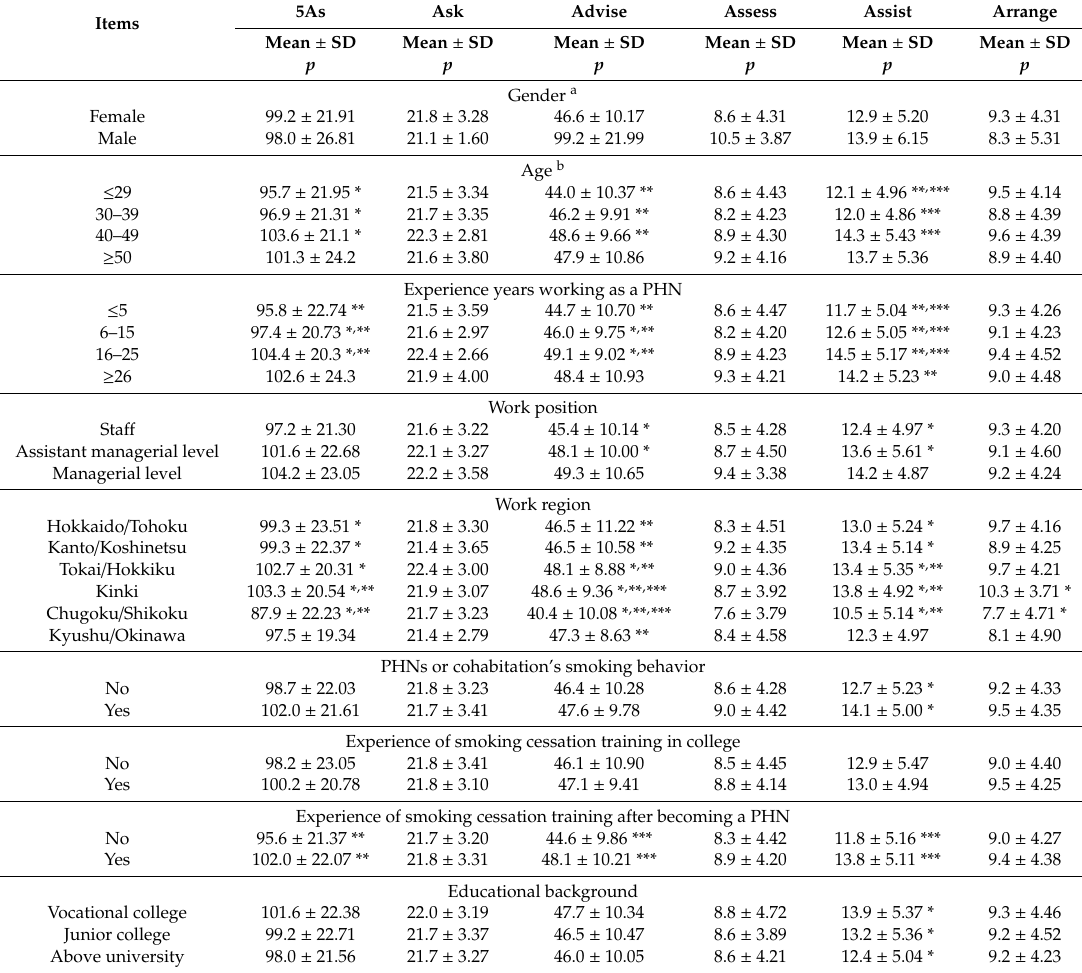
Table 2. Di ff erence of implementing the 5As by predisposing factors ( n = 521). 5As Ask Advise Assess Assist Items